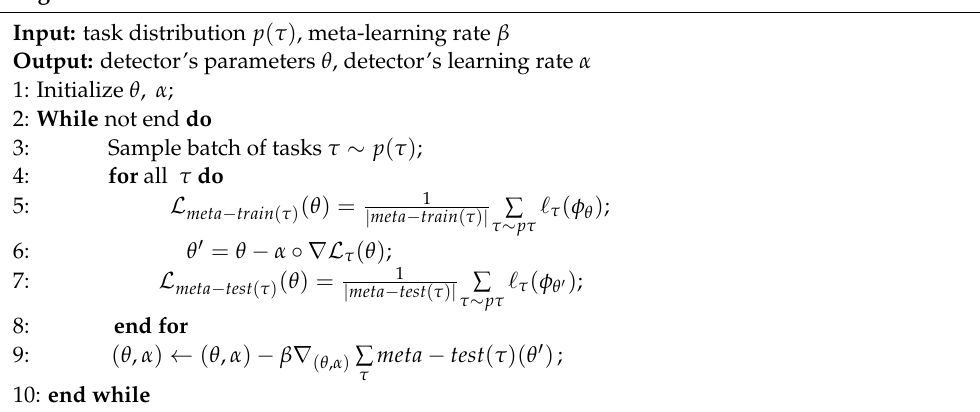
Algorithm 1 : Meta-Learner for Meta-YOLO